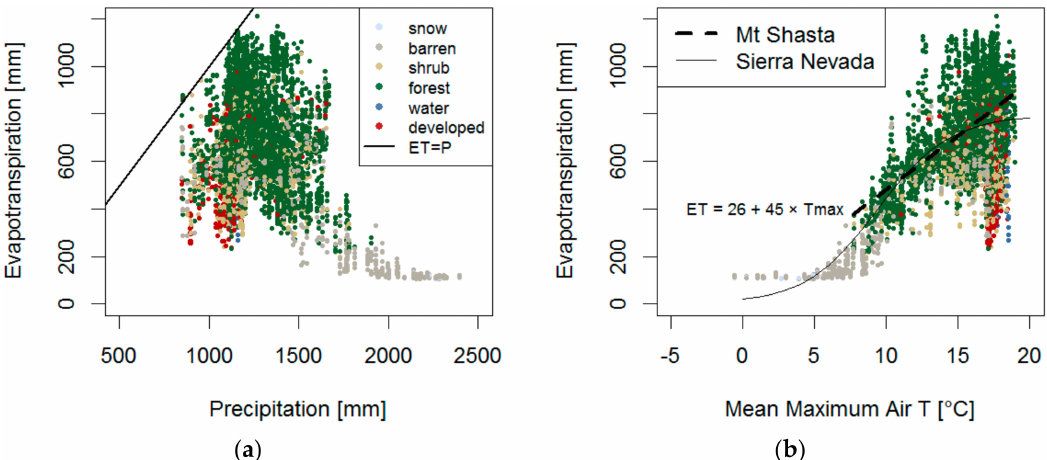
Figure 11. Evapotranspiration as function of precipitation ( a ) shows evapotranspiration does not exceed precipitation. A regression between evapotranspiration and mean maximum air temperature ( b ) shows a significant (R 2 = 0.35, p < 0.001) correlation with an increase in evapotranspiration of 45 mm per degree warming for forest land